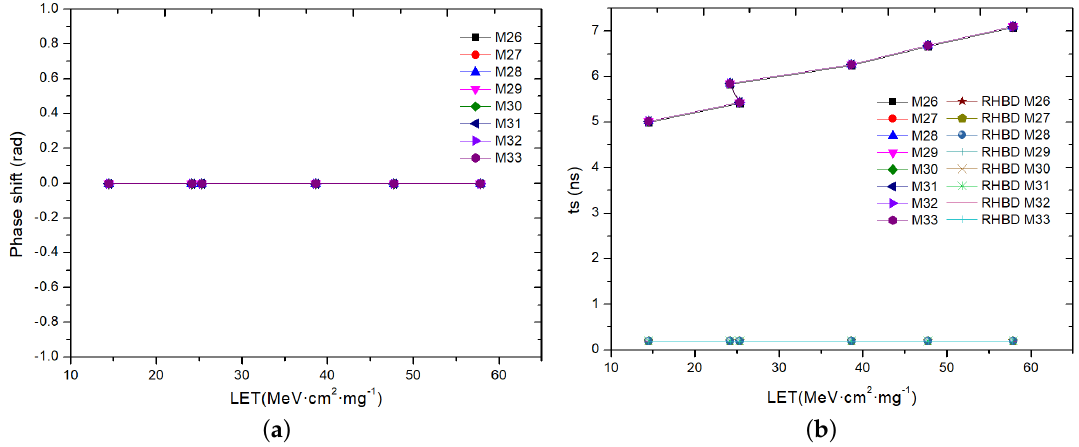
Figure 14. INP output of the RHBD MB results. ( a ) Phase shift; ( b ) Recovery